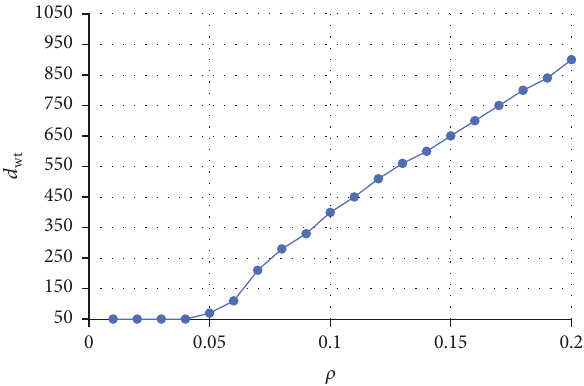
Figure 10: Relations between appropriate warning thresholds 𝑑 and 𝜌